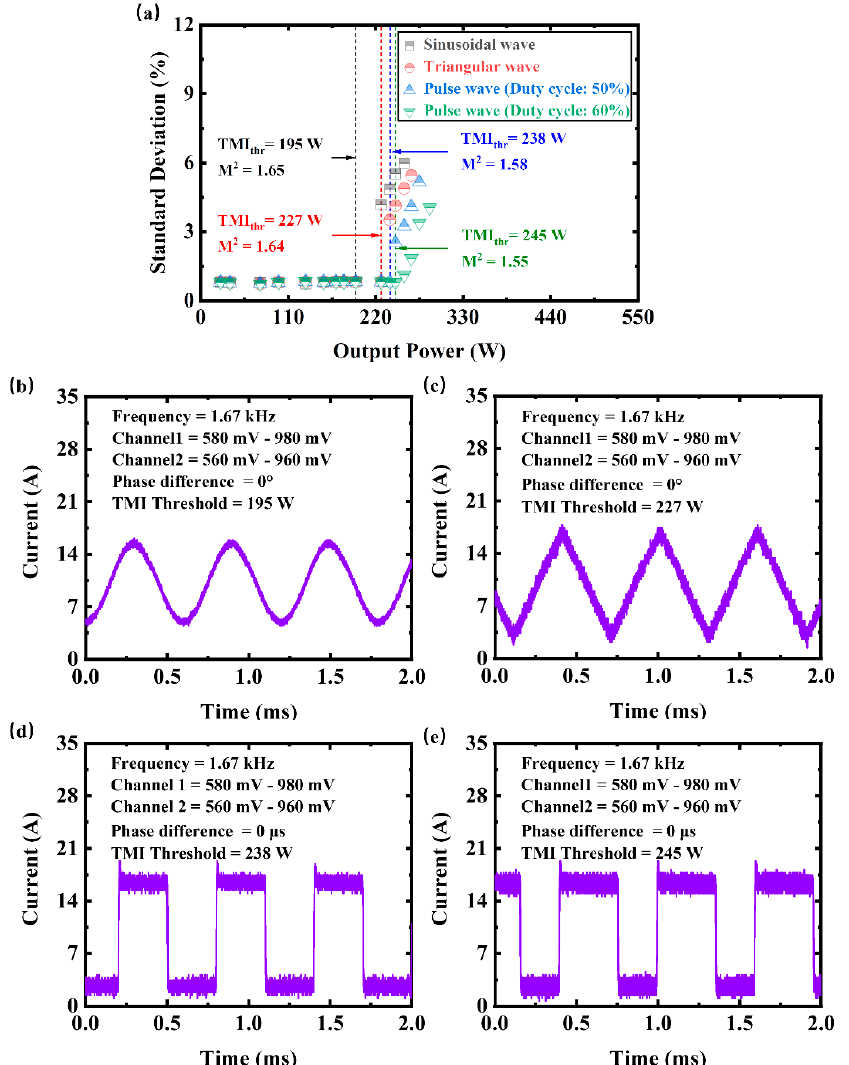
Figure 3. The output characteristic under the pump modulation of various waveforms with no phase difference between two channels of the function generator. ( a ) The evolution of the standard deviation of the beam fluctuations with the output power (the modulation frequency and its harmonics for the raw signals have been filtered out to calculate the temporal stability). Black dot: sinusoidal wave modulation. Red dot: triangular wave modulation. Blue dot: pulse wave (duty cycle: 50%) modulation. Green dot: pulse wave (duty cycle: 60%) modulation. The total current (purple line) of pump LDs at TMI threshold under the modulation of ( b ) sinusoidal wave, ( c ) triangular wave, ( d ) pulse wave (duty cycle: 50%), and ( e ) pulse wave (duty cycle: 60%).